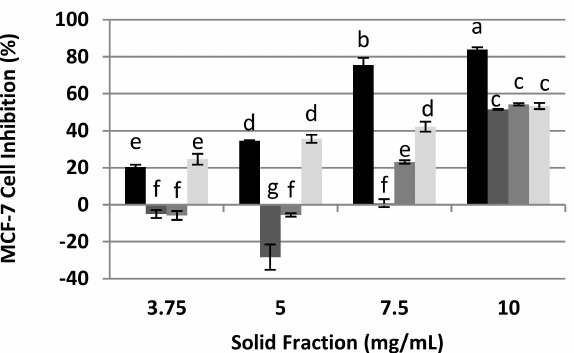
Figure 7. Effect of the molecular weight of the fractions obtained from the RPI (DH1) by ultrafiltration on the cellular inhibition of MCF-7. RPI (DH1) initial ( (cid:4) ), fraction I (>10 KDa) ( (cid:4) ), fraction II (3–10 KDa) ( (cid:4) ), fraction III (<3 KDa) ( (cid:4) ). Mean ± SD ( n = 3). The same letter means no significant difference ( p < 0.05), 95% confidence